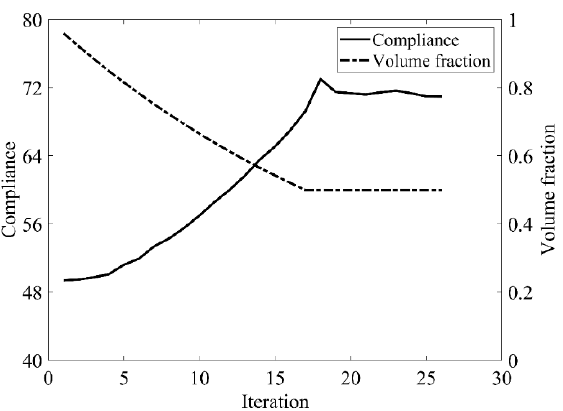
Figure 11. Convergence history of the compliance and the volume fraction for L-shaped beam by traditional BESO.